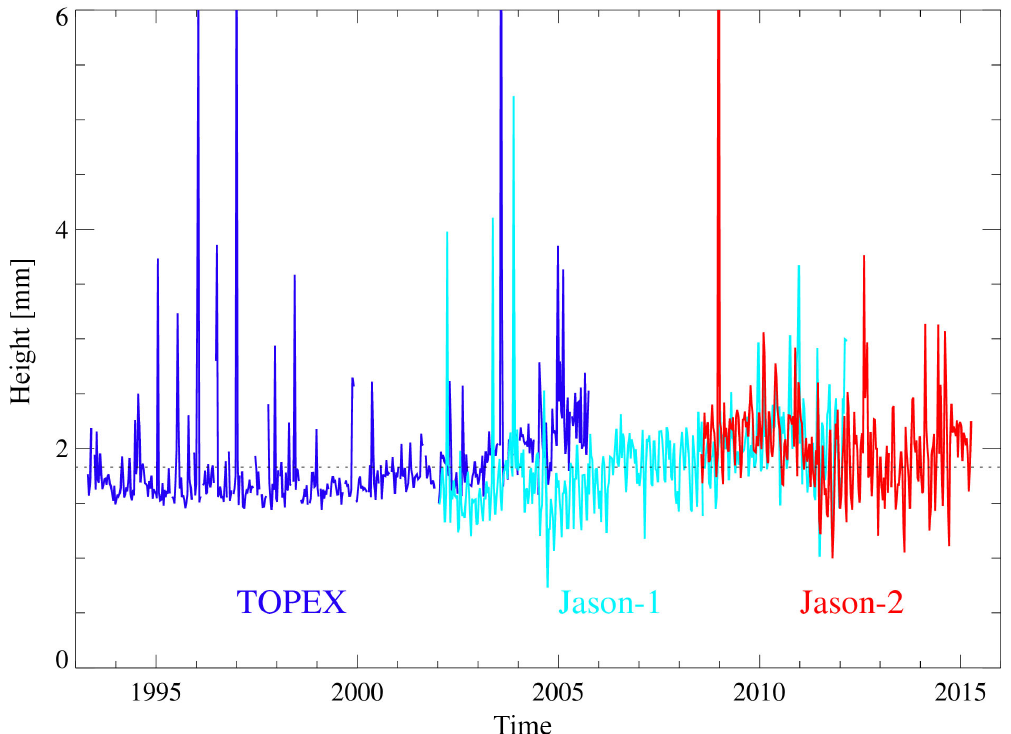
Figure 6. Global mean rms per cycle of gridded radial orbit differences (VER11-VER13) for TOPEX (blue), Jason-1 (cyan), and Jason-2 (red). The mean value is marked by the dashed